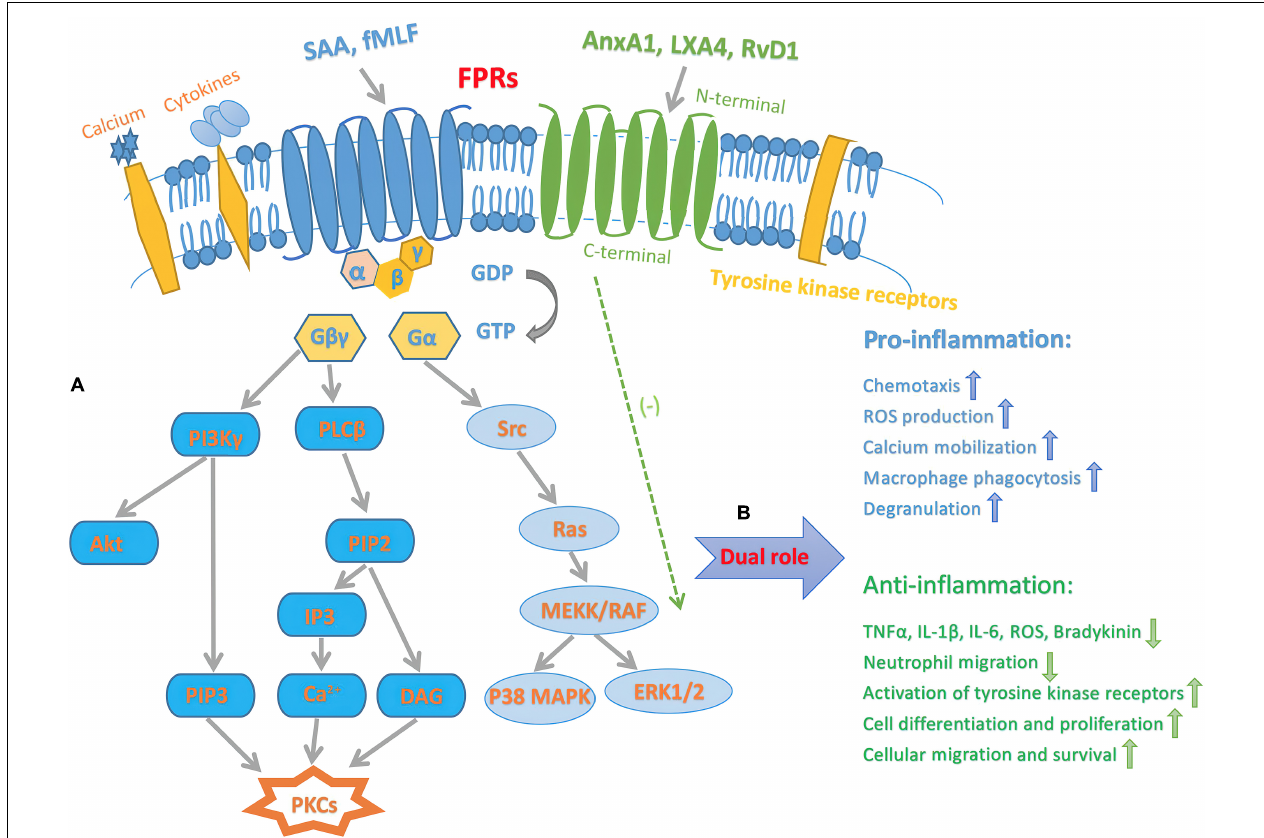
FIGURE 1 | Schematic diagram illustrating inflammatory signaling pathways of FPRs. (A) Intracellular transduction signaling pathway of FPRs. The activation of FPRs originates from sensing and binding PAMPs and DAMPs, results in the dissociation of the G α from the G βγ subunit. The latter activates PLC β , resulting in release of calcium from intracellular stores then activate PKCs. Another pathway triggered by the βγ subunit is that PI3K γ activate PKCs and Akt. Furthermore, α subunit activates GTPases of the Ras superfamily, which further contribute to activation of the MAPK pathways, p38, and ERK1/2. (B) Dual pro-inflammatory and pro-resolving effects of FPRs signaling. Endogenous SAA and bacterial original fMLF bind to FPRs, mediate pro-inflammatory actions, such as chemotaxis, superoxide anion production, calcium mobilization, macrophage phagocytosis, and degranulation. On the other hand, FPRs pro-resolving agonists include AnxA1, LXA4, and RvD1. This process prevents producing TNF α , IL-1 β , IL-6, ROS, bradykinin and inhibit neutrophil migration. Furthermore, the pro-resolving procedure deactivates tyrosine kinase receptors, leading to downstream signaling event that promote cell differentiation and proliferation, as well as enhancing cellular migration and survival. G α , G-protein α ; G βγ , G-protein βγ